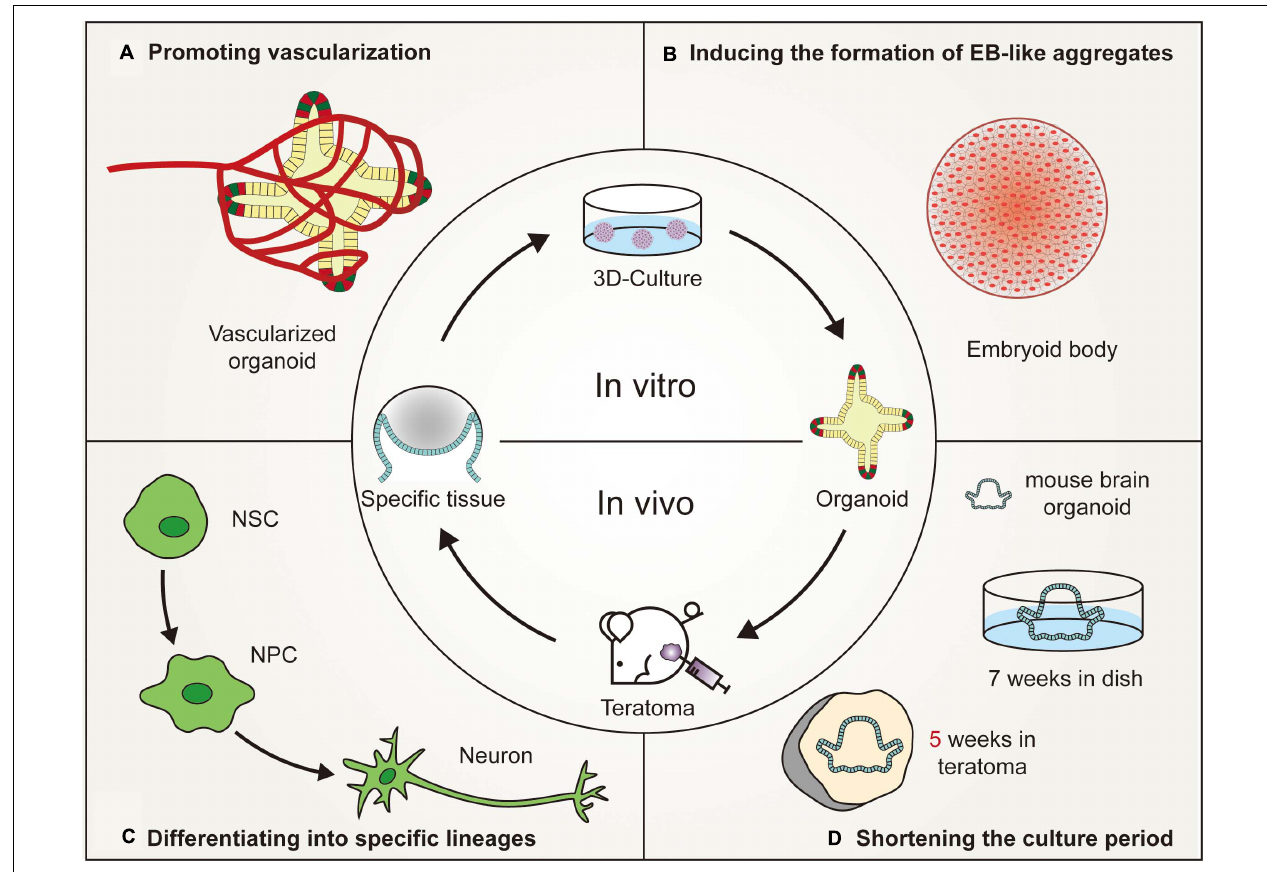
FIGURE 2 | Advantages of in vivo teratoma systems to better generate organoids. (A) Vascularized tissues could be isolated from in vivo teratomas by genetic engineering and then cultured in vitro to generate vascularized organoids. (B) Pluripotent stem cells (PSCs), showing poor embryoid-body (EB)-forming ability in vitro , are usually defective in the initial stage of differentiation. However, the PSCs could form teratomas in vivo to generate embryoid-body-like aggregates to promote organoid formation. (C) By combining teratoma systems with genetic engineering technology, teratoma systems could be used to enrich specific lineage cells with more accuracy to better generate organoids and improve the reproducibility of organoids. (D) Mouse embryonic stem cell-derived brain organoids, which are produced in 7 weeks by in vivo 3D culture, could be generated in 5 weeks by in vitro culturing nerve tissues isolated from teratomas (NSC, neural stem cell; NPC, neural progenitor